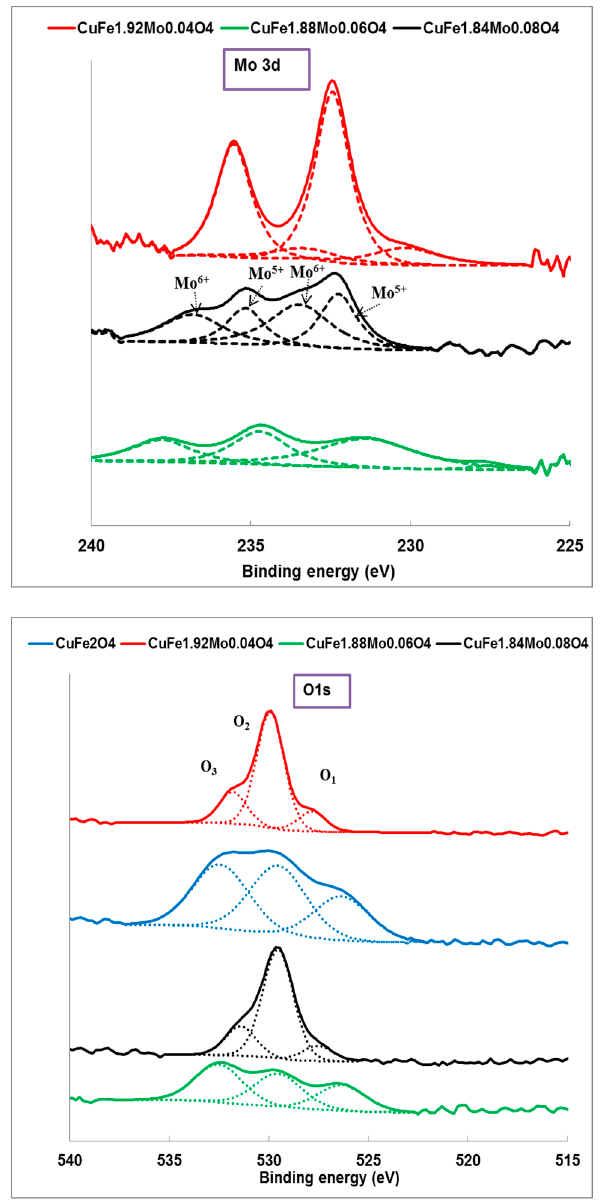
Figure 5. XPS spectra of copper ferrites dopped with molybdenum.